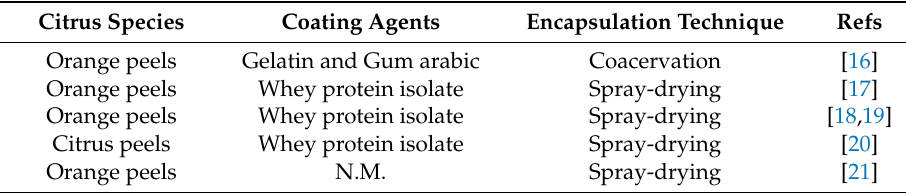
Table 1. Summary of studies on the encapsulation of citrus pomace